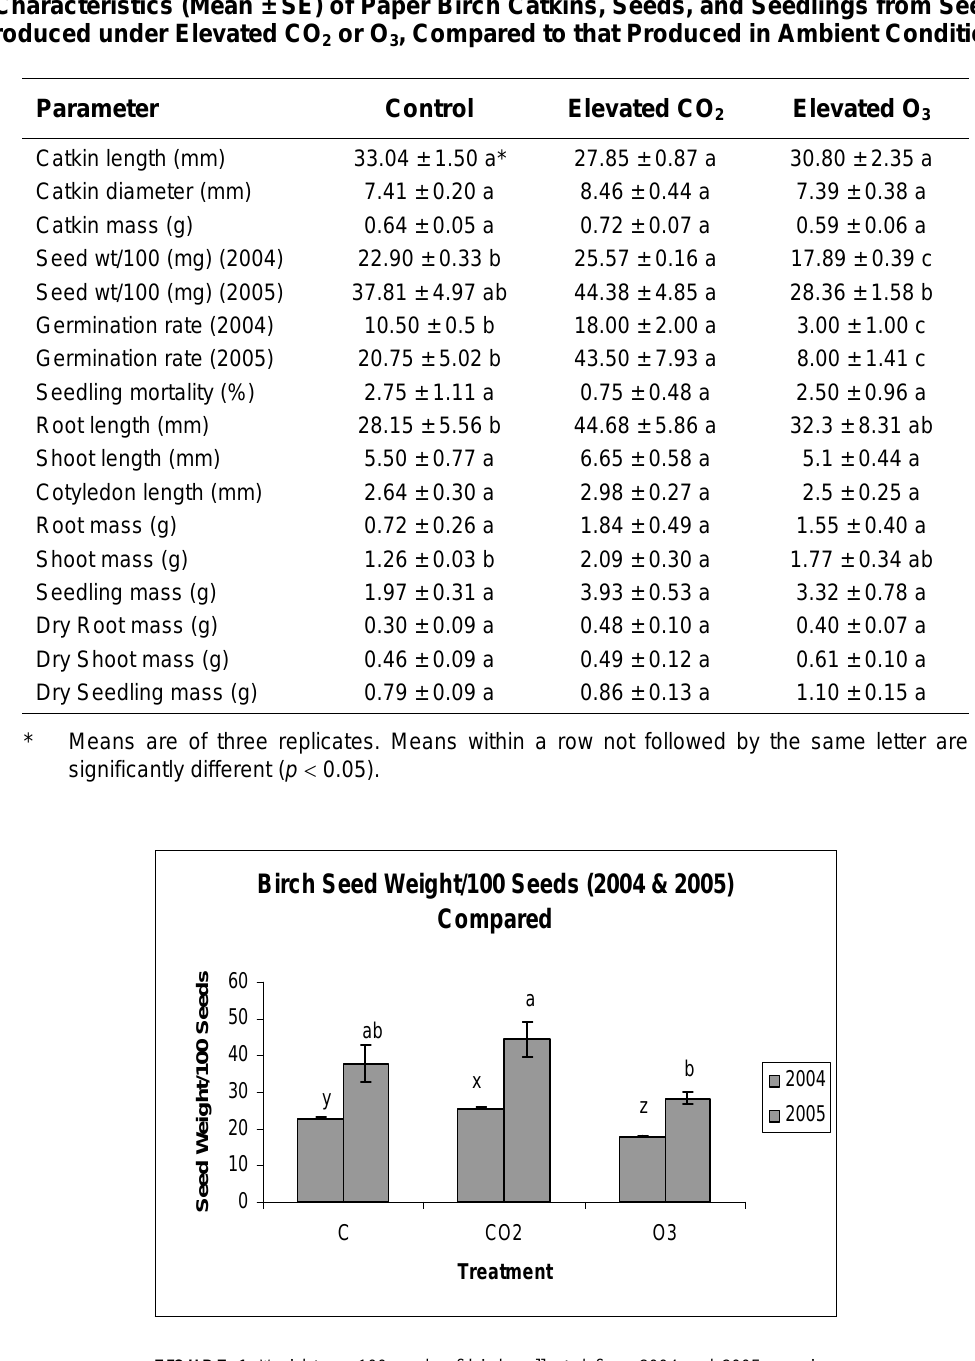
the 2 years: 71% in 2004 and 110% in 2005 seeds, respectively. Seed produced under elevated O greatly decreased germination rate: 71% decrease in 2004 and 61% decrease in 2005 seeds, respectively, as seen from Fig.